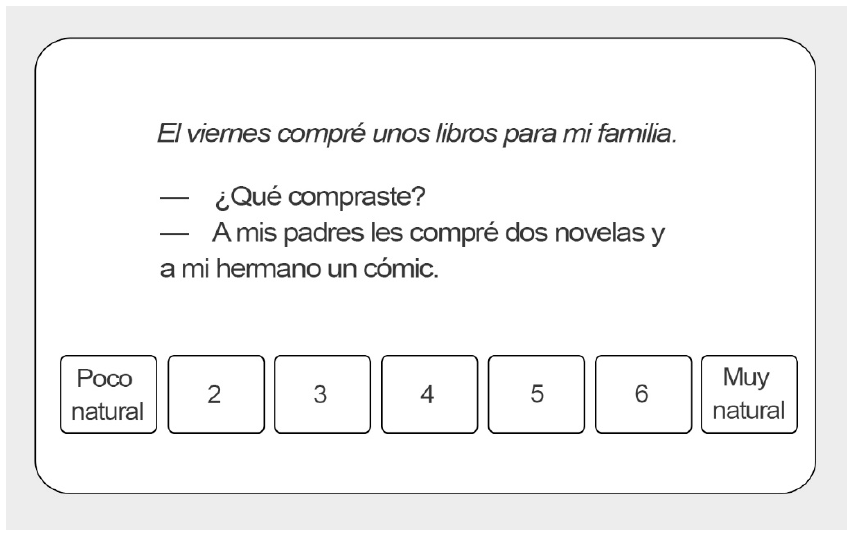
Figure 1. Procedure of experiment 1. Example of the screens that participants saw during one item of the experiment.